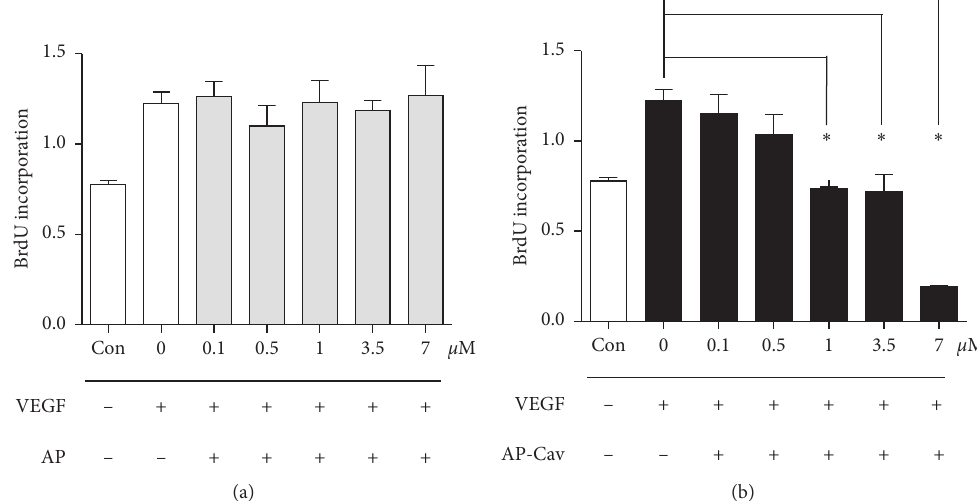
Figure 1: AP-Cav inhibits mouse colon endothelial cell proliferation. (a) AP peptide pretreatment shows no effect on colon endothelial cell proliferation. (b) AP-Cav inhibits endothelial cell proliferation induced by VEGF. Cells were treated with peptide at indicated concentrations for 30 minutes before being treated with VEGF (50ng/ml) for 4 hours. Data are mean ± s.e.m. from three independent experiments ∗ p < 0 . 05.